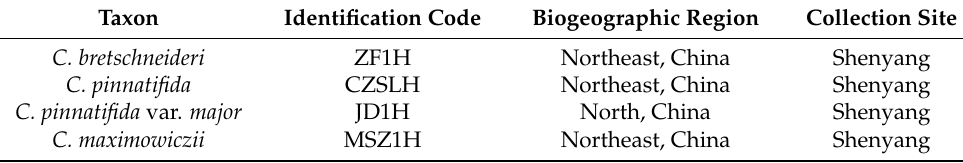
Table 1. Biogeographic regions and sample collection sites of four Crataegus species. Taxon Identification Code Biogeographic Region Collection